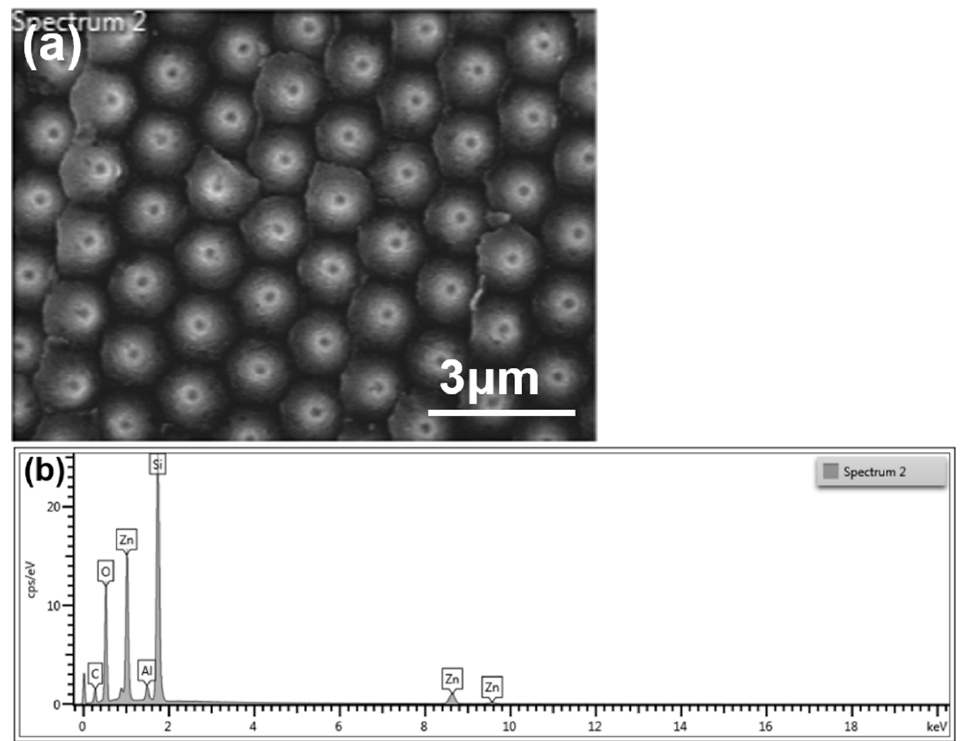
Figure 5. ( a ) Sample used in the EDS analyses; ( b ) the EDS analysis results for the SC ‐ B substrate. Table 1. Results of the EDA analyses of prepared ZnO seed layers for the three substrates. wt% and at%: percentage by weight and atomic percentage.